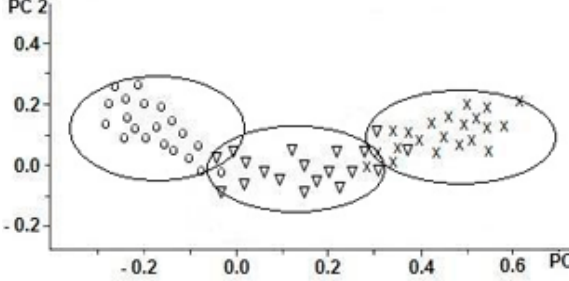
Figure 1. The Principal Component Analysis (PCA) score plot of mass spectrometry spectra illustrates the clustering of samples according to attributed group membership (negligible (×), gradual ( Δ ), and rapid aging (O)), with more than 80% of total variance (the first two components). The clustering displays a difference in the metabolic composition between the compared groups.